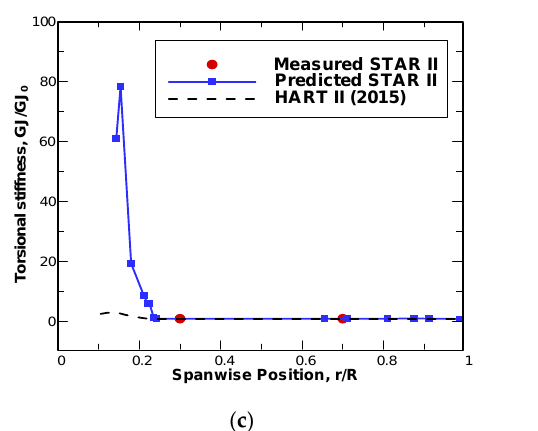
Figure 16. Comparison of blade structural properties (nondimensionalized by their uniform values). ( a ) Axial rigidity, ( b ) flap bending rigidity, ( c ) torsional rigidity, ( d ) section CG offsets, ( e ) mass per unit length, and ( f ) polar MOI.